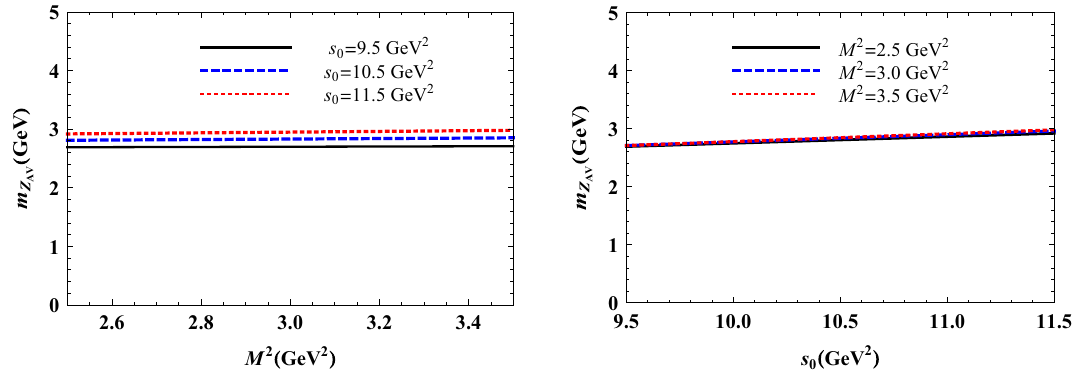
Fig. 9 The mass of the Z AV state vs Borel parameter M 2 at fixed values of s 0 (left panel), and vs continuum threshold s 0 at fixed values of M 2 (right panel)